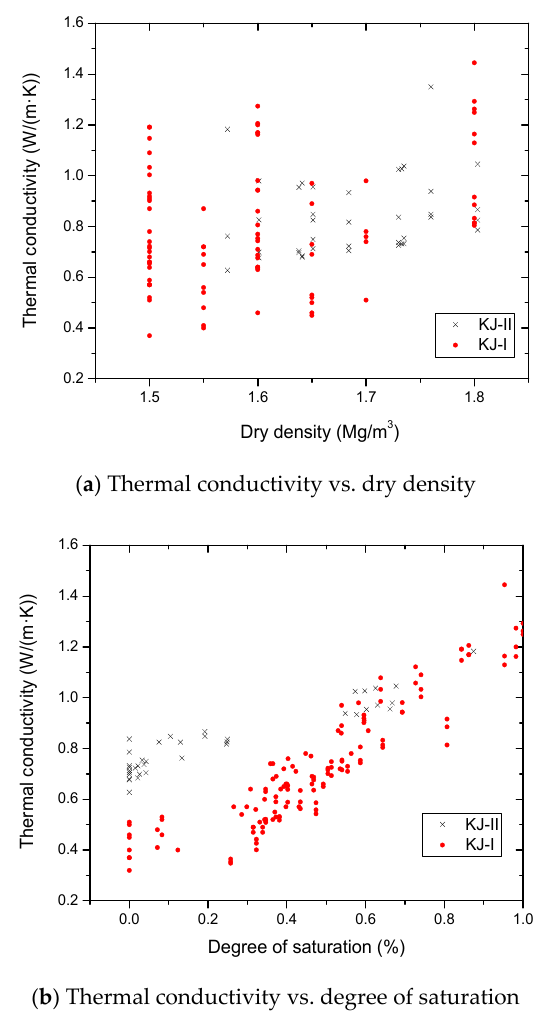
Figure 3. Thermal conductivity variation KJ bentonites.